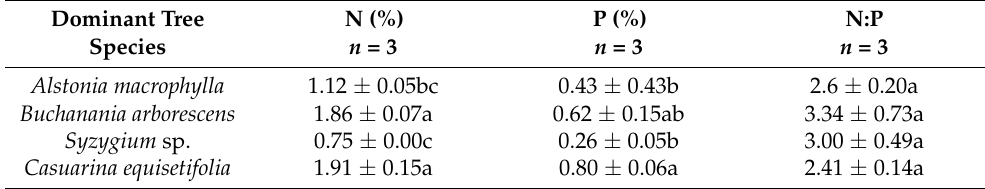
Figure 2. Relative abundance of ( a ) native and ( b ) non-native tree species in Hinatuan Island, Taganaan, Surigao del Norte, Philippines. Table 3. Analysis of variance for leaf N, leaf P, and leaf N:P ratios of the top-three dominant tree species from native and non-native origin in ultramafic areas affected by mining activities in Hinatuan Island, Taganaan, Surigao Del Norte,